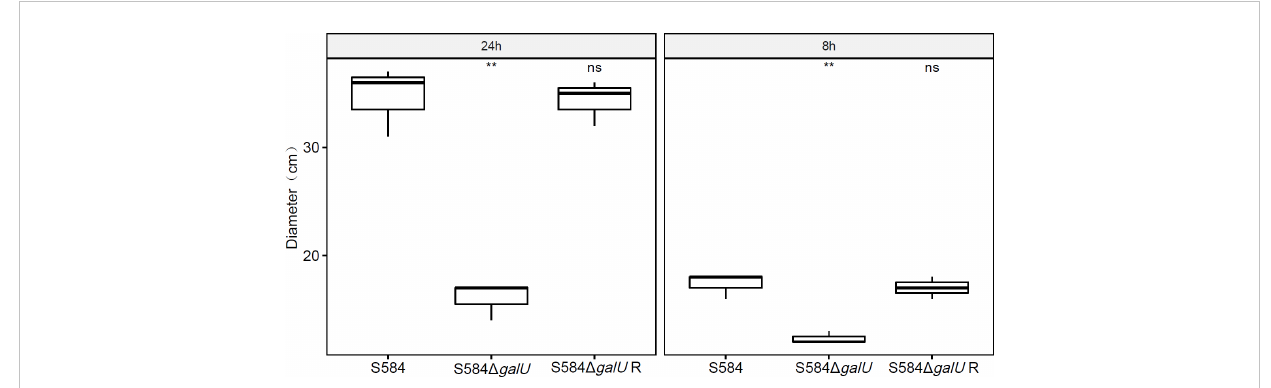
FIGURE 5 Results of motility analysis for the three strains at 8 and 24 h. The vertical coordinate of the graph shows the movement diameter (cm) for each strain cultured on Luria – Bertani (LB) plates after 8 and 24 h. Ns means no signi fi cant difference. ** means signi fi cant